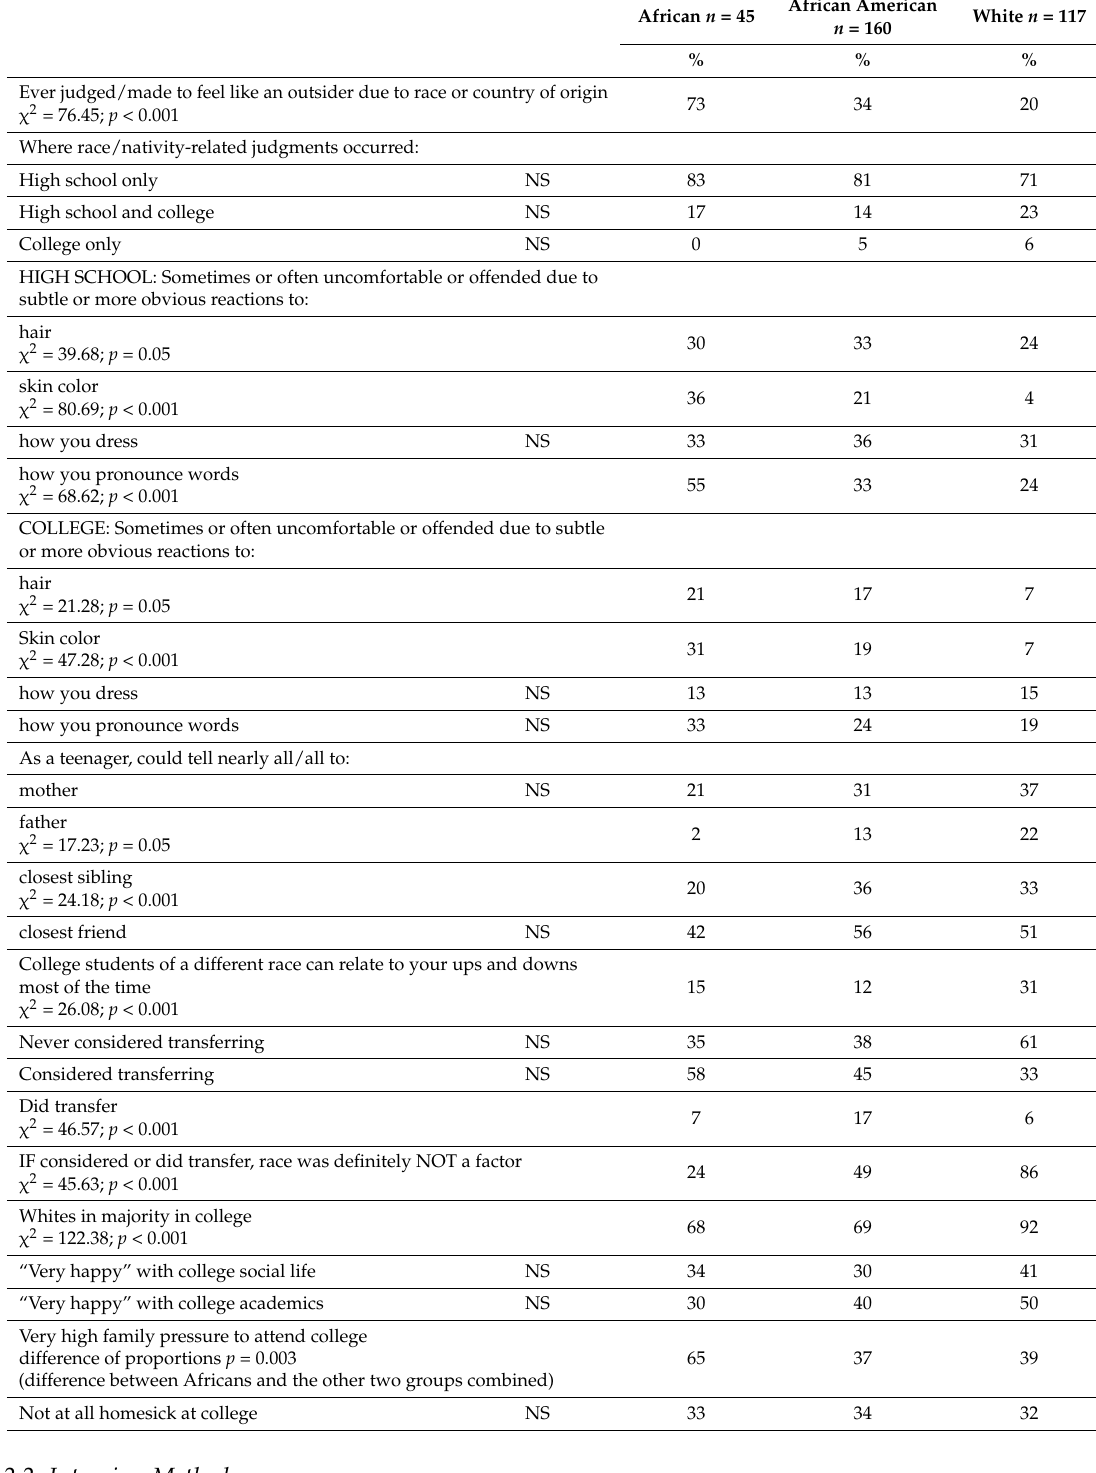
Table 1. Qualtrics Survey